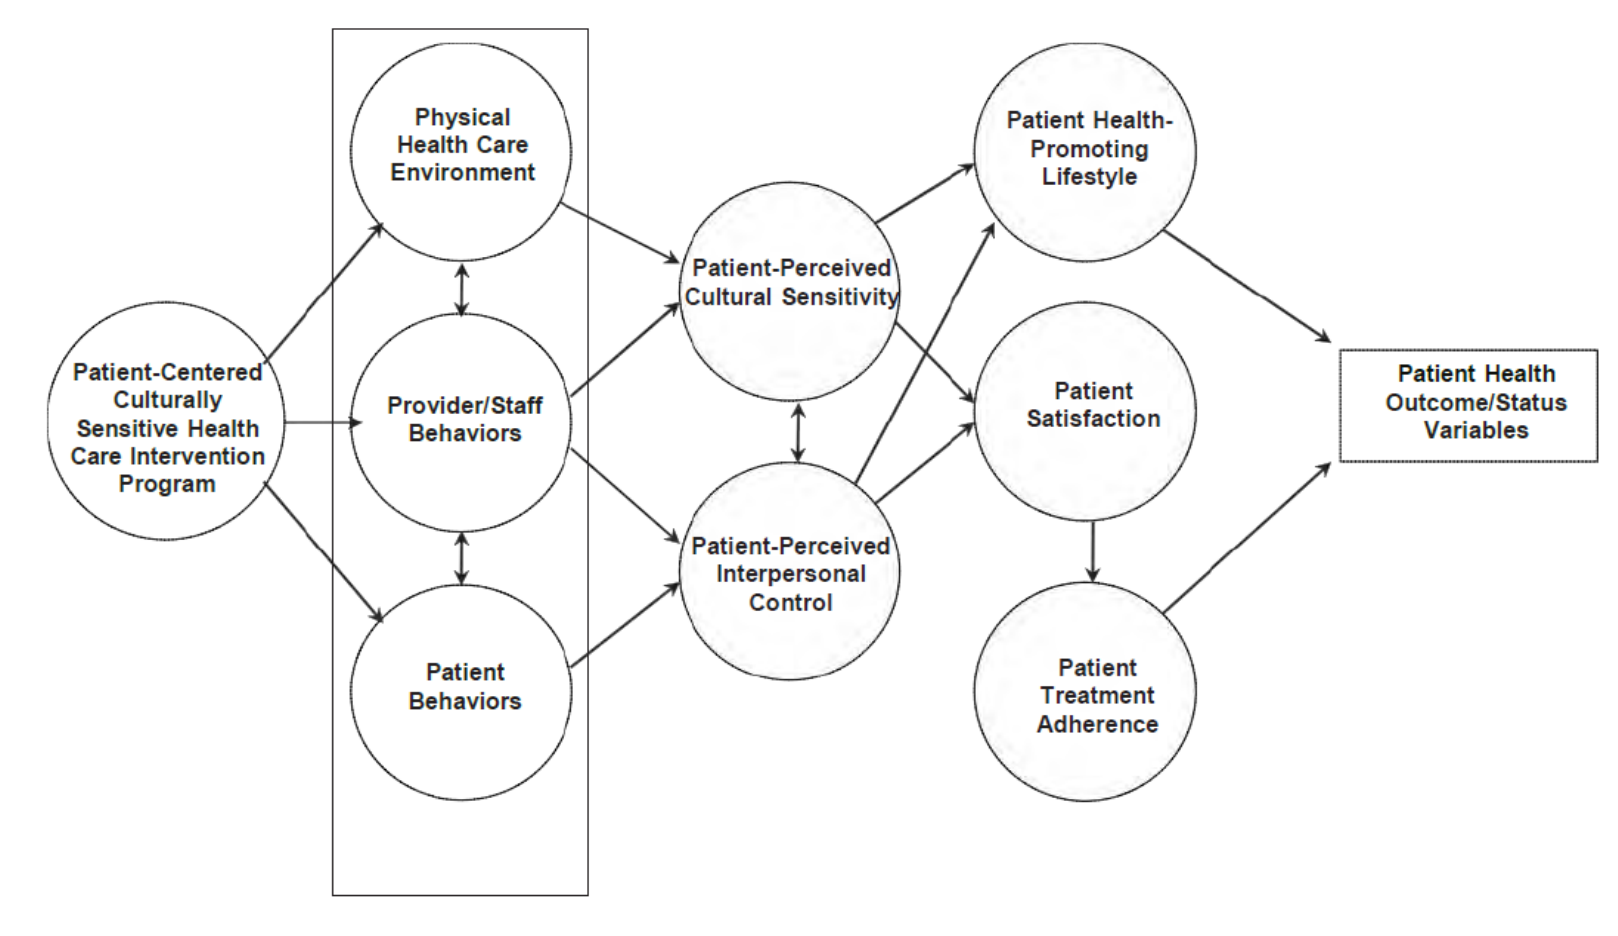
Figure 1. Patient-Centered Culturally Sensitive Health Care